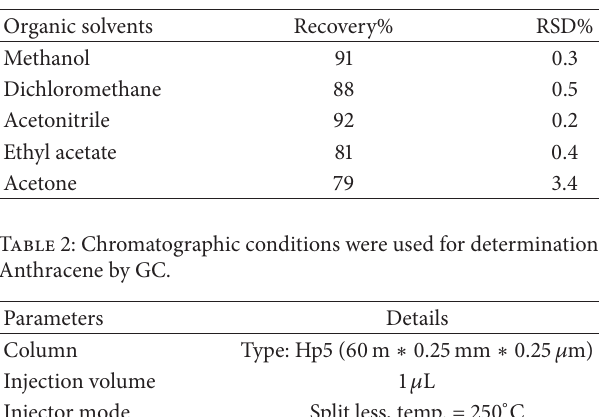
Table 1: The average recovery of Anthracene and relative standard deviations RSD ( 𝑛 = 5 ).